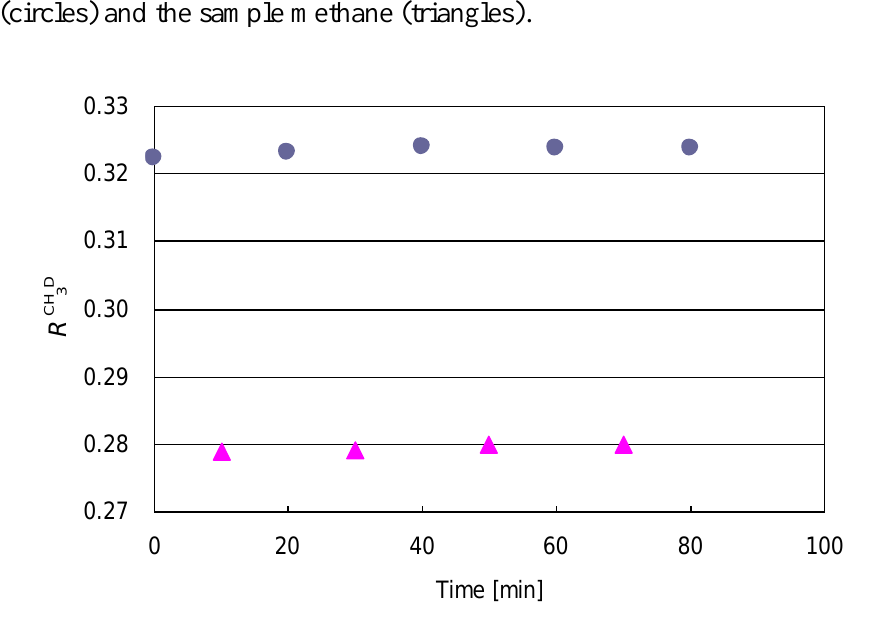
D/ 12 CH of the working 3 4